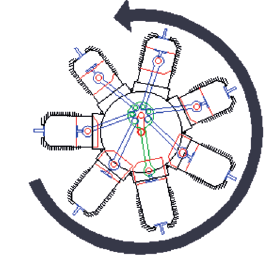
Fig. 3. Radial-type engine